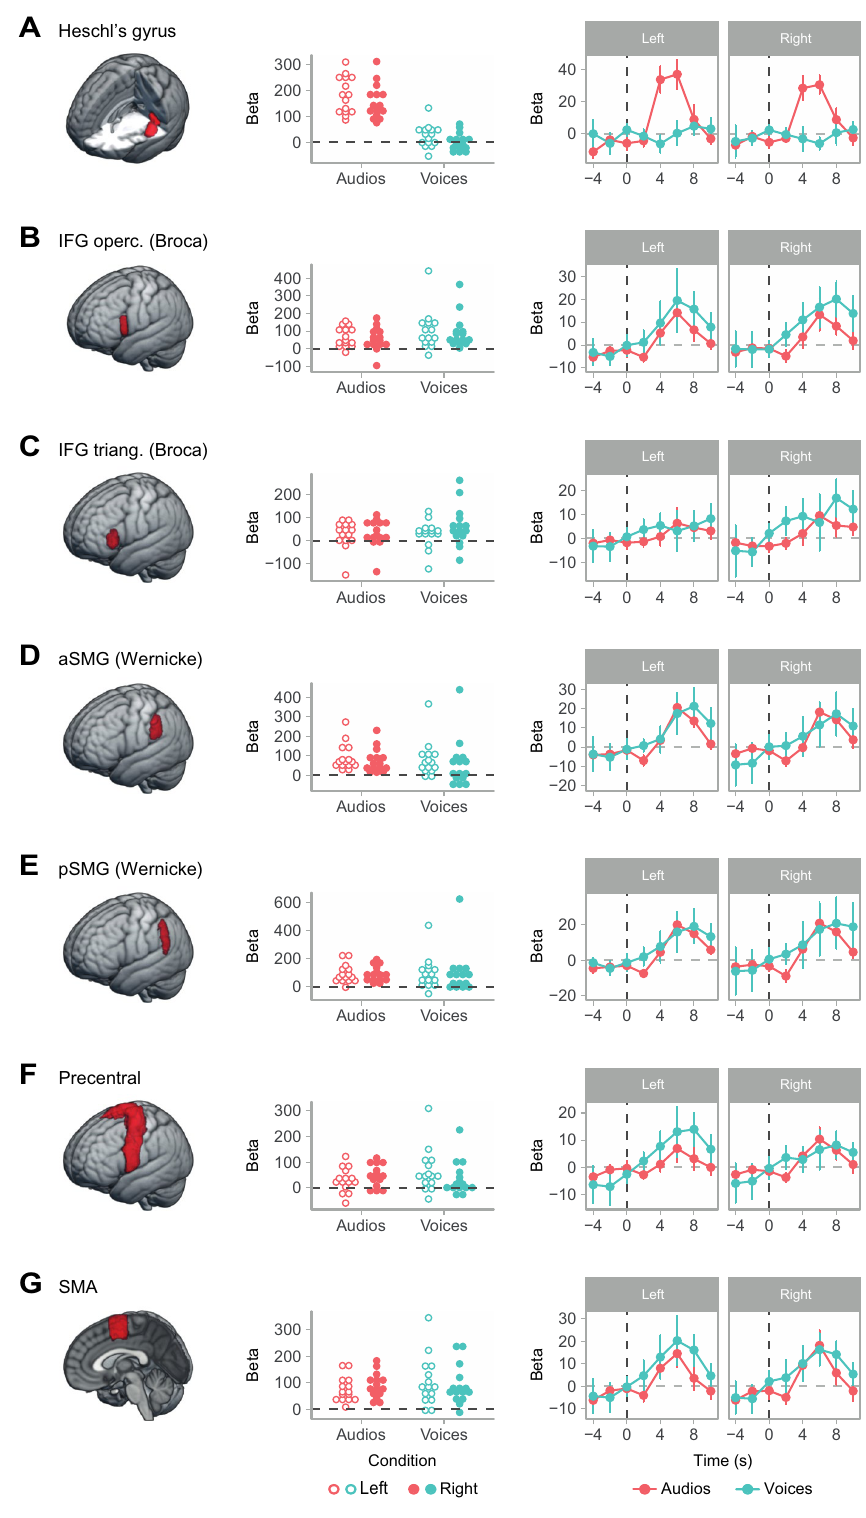
Figure 3. Task-related activation in anatomically-defined ROIs for auditory perception, language processing and motor regions. Dot plots show individual mean activation levels (beta values) for real auditory stimuli and AVH in Heschl’s gyrus (A) , the inferior frontal gyrus, pars opercularis (B) , the inferior frontal gyrus, pars triangularis (C) , the anterior portion of the supramarginal gyrus (D) , the posterior supramarginal gyrus (E) , the precentral gyrus (F) and the supplementary motor area (G) . Time-series plots show group signal change in the same ROIs relative to the region’s average, in the time window spanning 4 s before to 10 s after stimulus presentation (estimated stimulus occurrence time in the case of